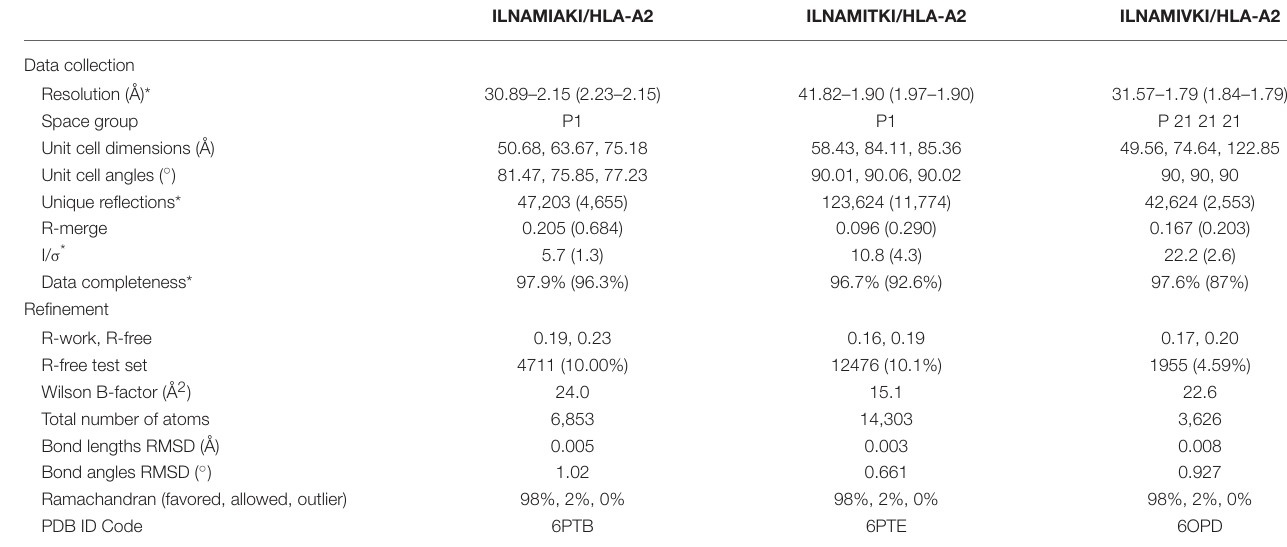
TABLE 1 | X-ray data collection and refinement